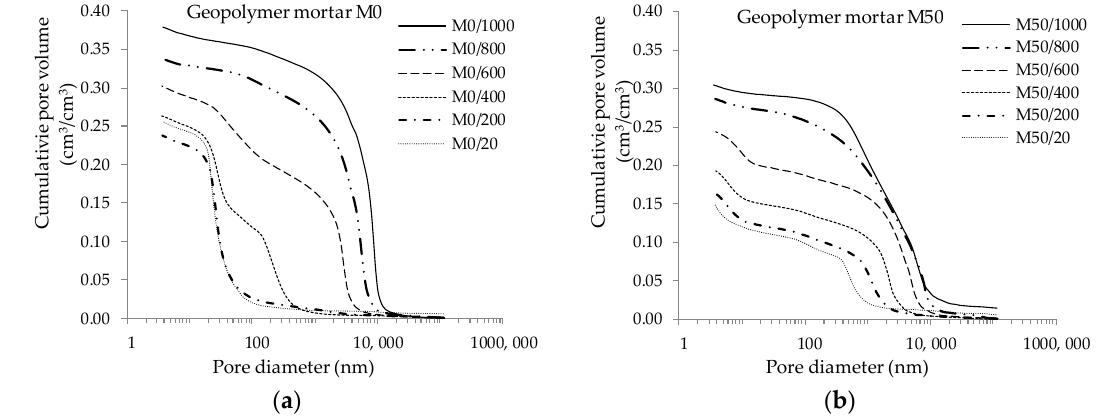
Figure 2. Total porosity: ( a ) mortars based on FA only; ( b ) mortar with GGBFS addition.